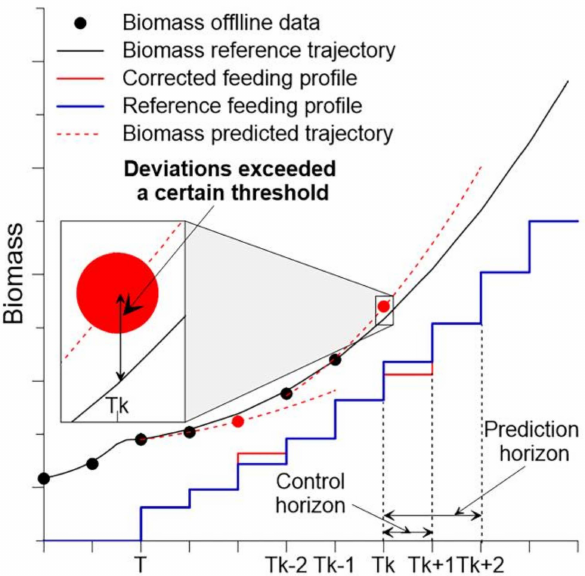
Figure 9. MPC operation principle [82]. The model estimates the values of cell biomass in the prediction horizon and adjusts the substrate feeding profile to minimize the deviation from the biomass reference